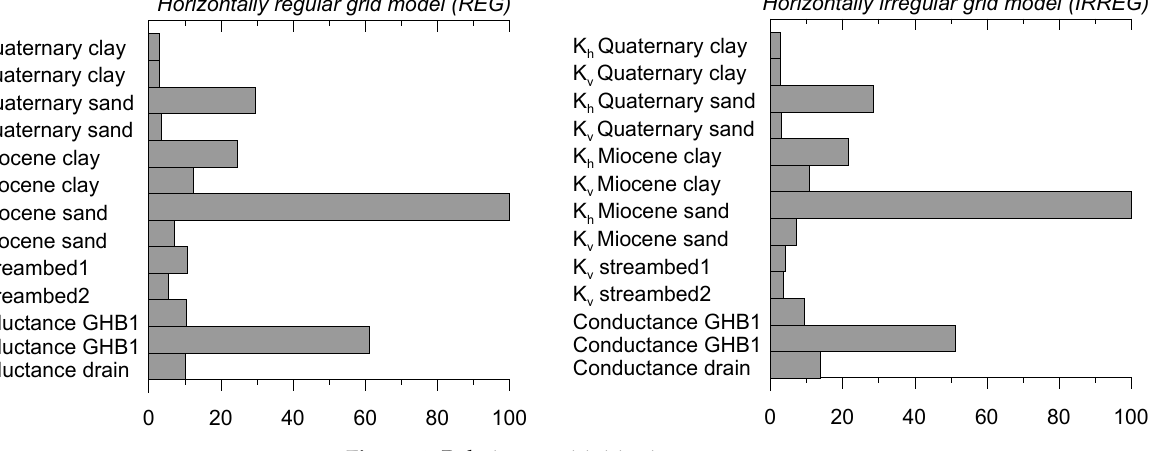
Figure 4. Relative sensitivities in percent.